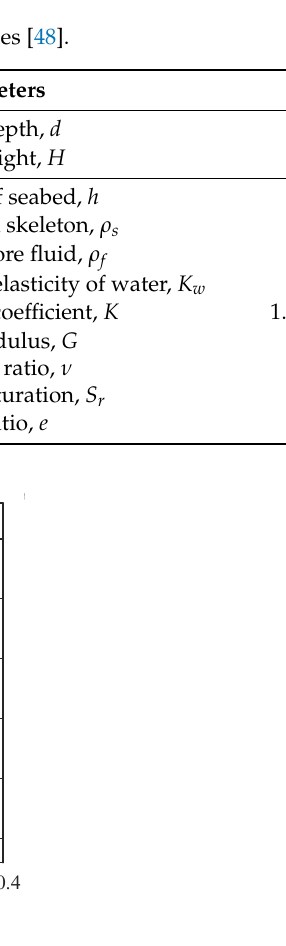
Figure 5. Comparisons of the vertical distributions of the maximum pore pressure between the experimental results by Qi et al. [48] (markers) and the present semi-analytical solution (dashed line).